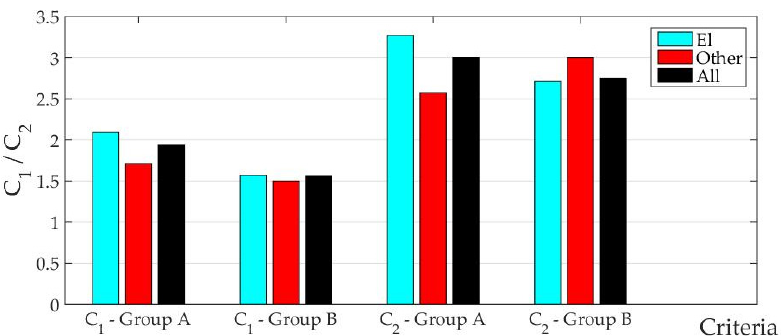
Figure 9. Mini-project test results by study tracks and evaluation criteria: C 1 —CPU instruction extensions; C 2 —complexity of the CPU architecture extension.